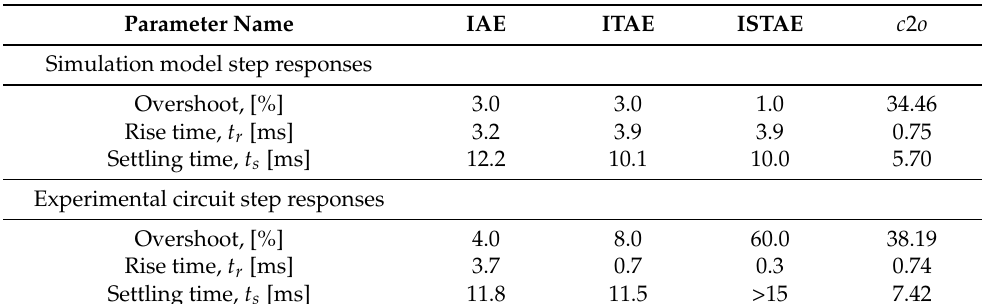
Table 3. Selected parameters of step responses from Figure 9 for gains obtained with unconstrained GA optimization, shown in Table